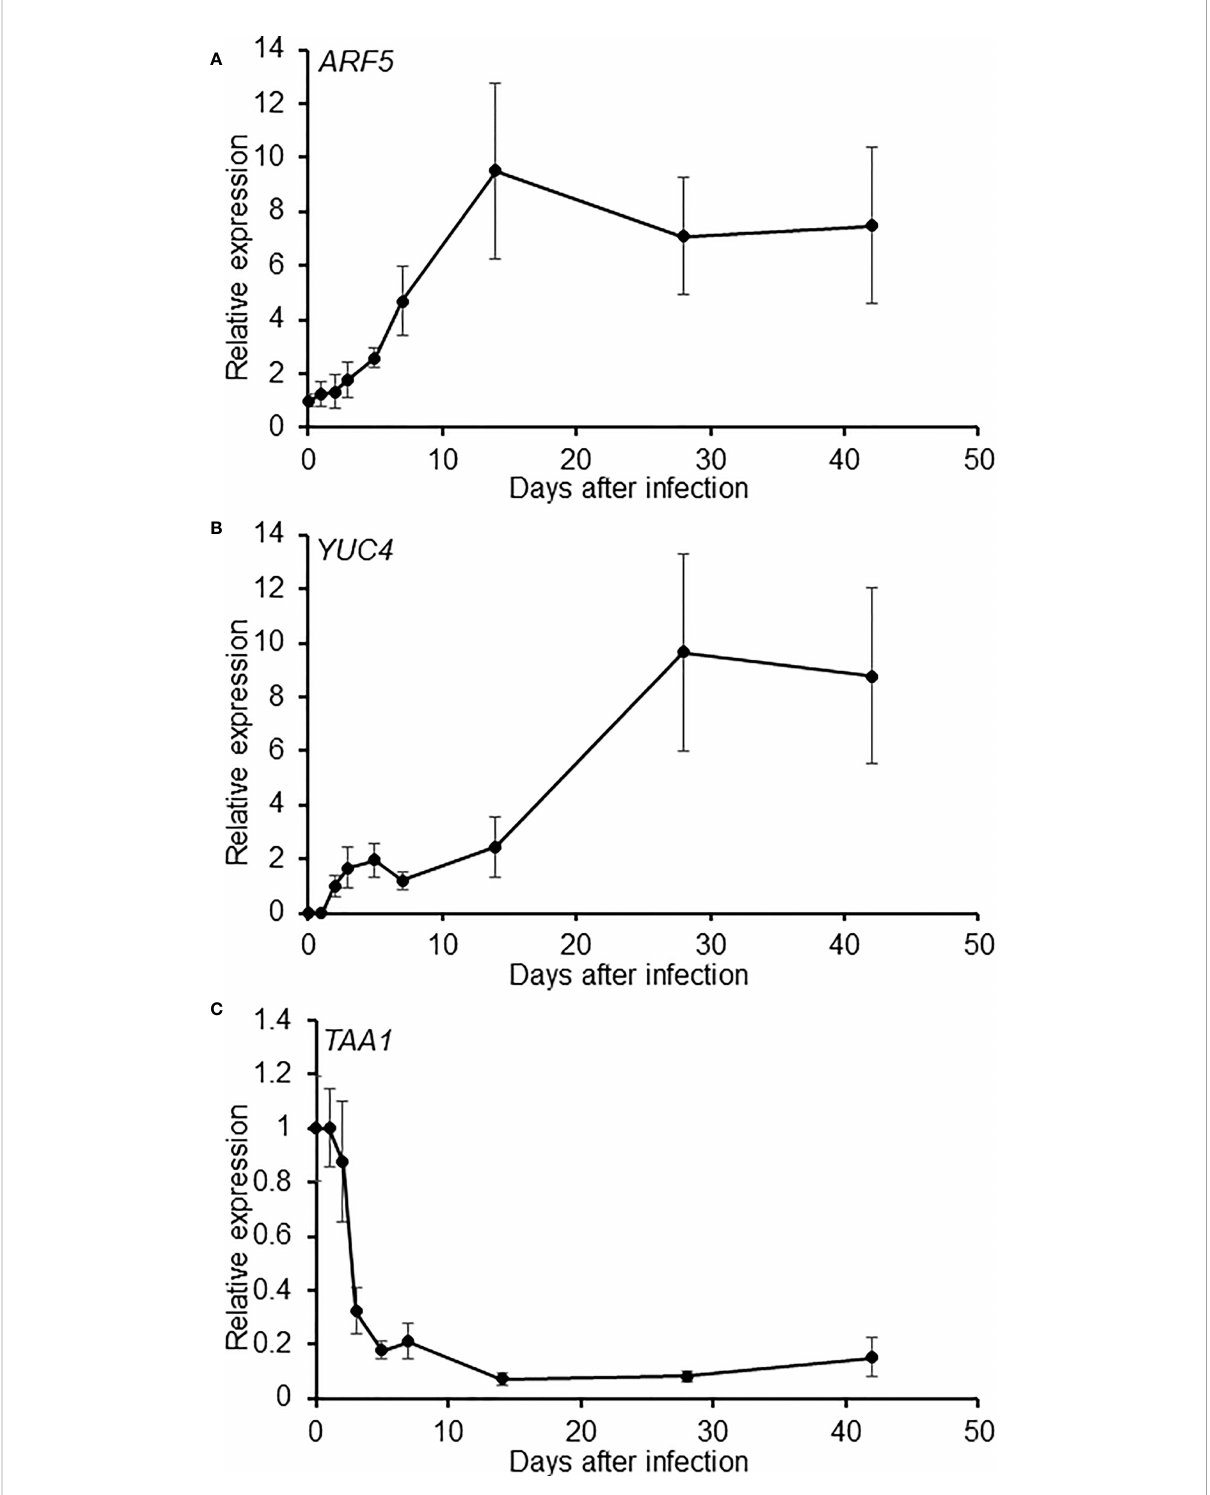
FIGURE 3 Expression of auxin metabolism genes are regulated during gall development. Relative expression levels of ARF5 (A) , YUC4 (B) and TAA1 (C) quanti fi ed by qRT-PCR during gall development. Values were normalized to the earliest available time point. Averages of n = 9 ± SE are shown. Three biological replicates were performed with similar